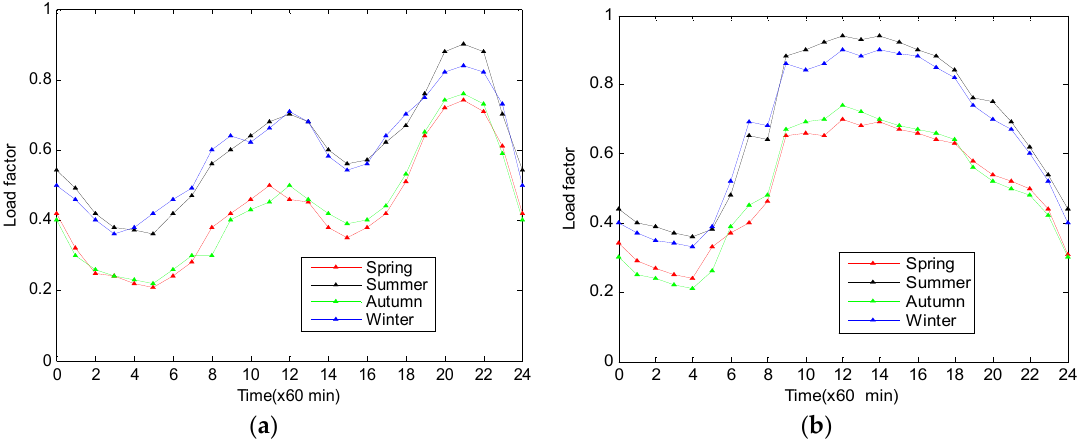
Figure 3. The typical daily curves of residential load and commercial load under four seasons. ( a ) The typical daily curves of residential load; ( b ) The typical daily curves of commercial load.